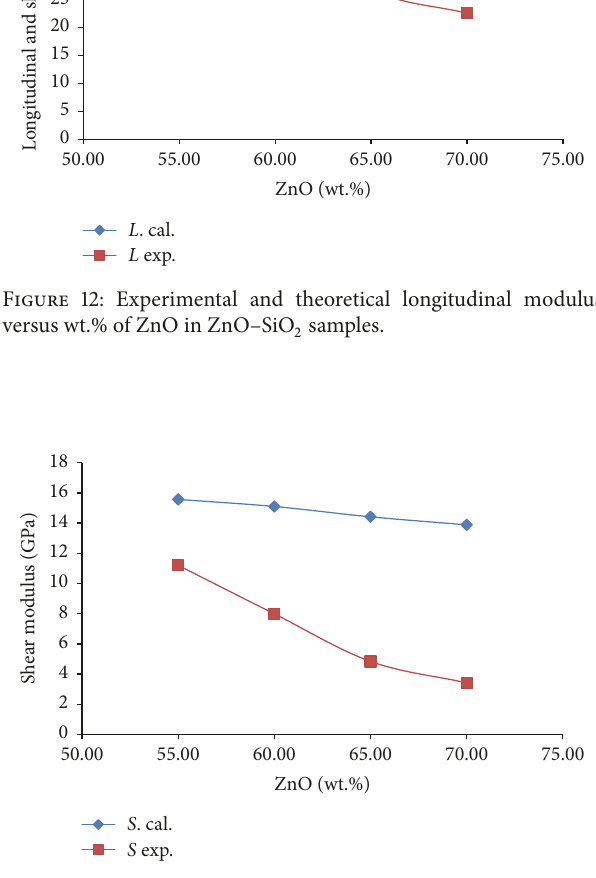
Figure 13: Experimental and theoretical shear modulus versus wt.% of ZnO in ZnO–SiO 2 samples.